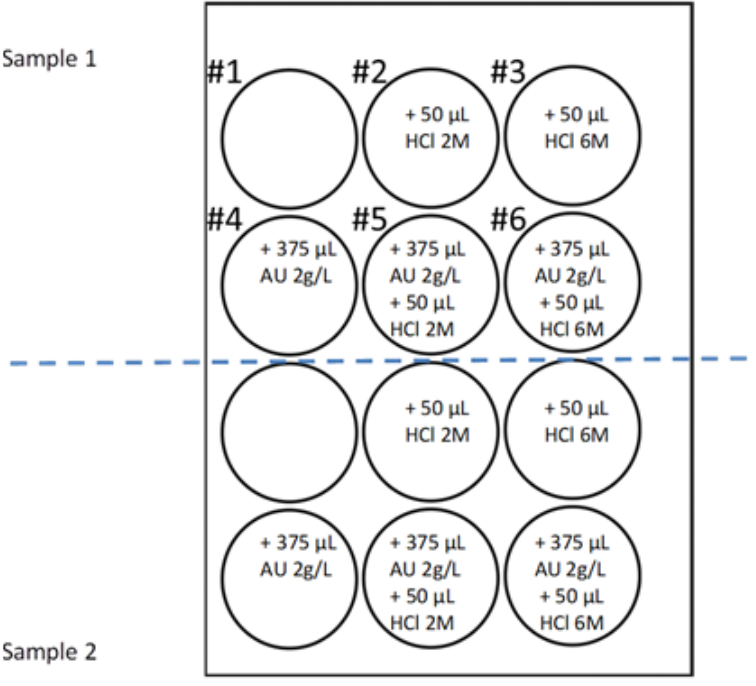
Figure 1. Uric acid crystallization (UAC) test. Six wells of a 12-well plate were used for each sample of urine, with each well containing 5 mL of urine and different amounts of HCL and uric acid. Well #1 had urine alone, well #2 had urine and 50 µ L of 2 M HCl (0.1 mmoL H + ), well #3 had urine and 50 µ L of 6 M HCl (0.3 mmol H + ), well #4 had urine and 750 µ g uric acid (375 µ L of 2 g/L solution), well #5 had urine, 50 µ L of 2 M HCl and 750 µ g uric acid, and well #6 had urine, 50 mL 6 M HCl and 750 µ g uric acid. Uric acid (AU). + means addition of the specified volume of the